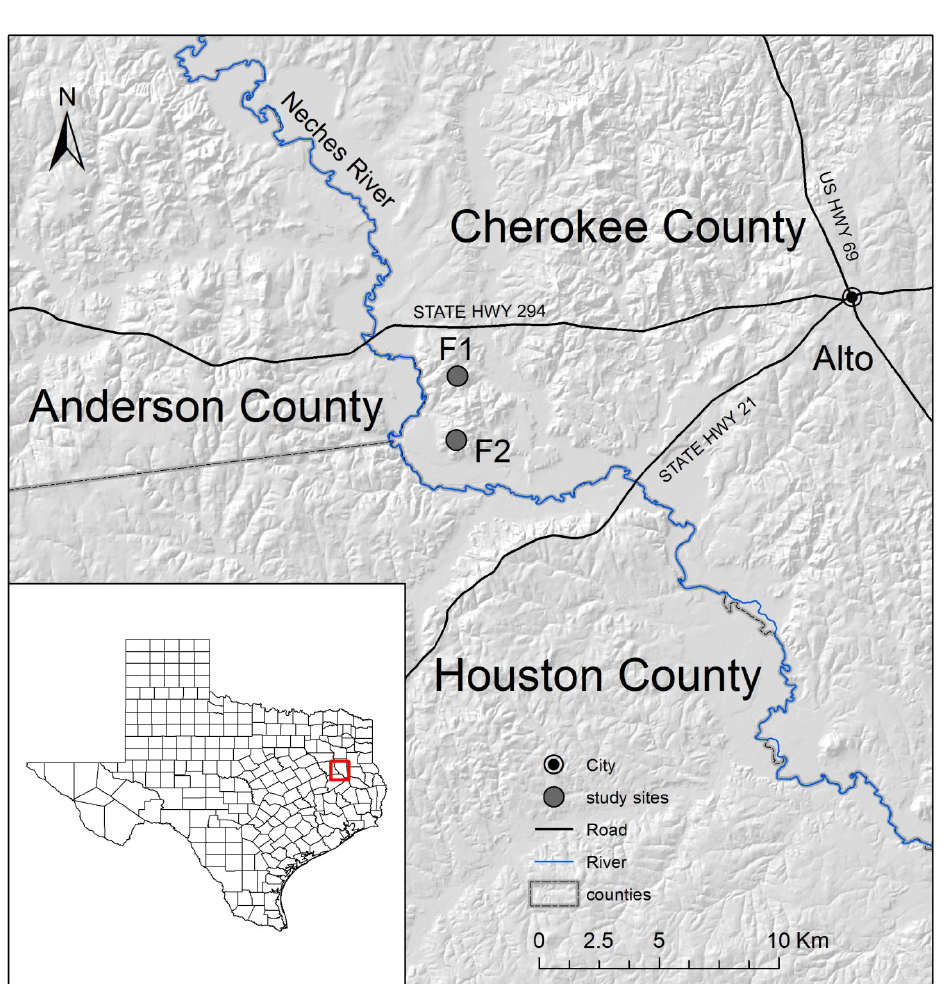
Figure 1. Location of study watersheds (F1 = no riparian buffer, F2 = 15 m riparian buffer) at the Alto Experimental Watersheds in Cherokee County, Texas,